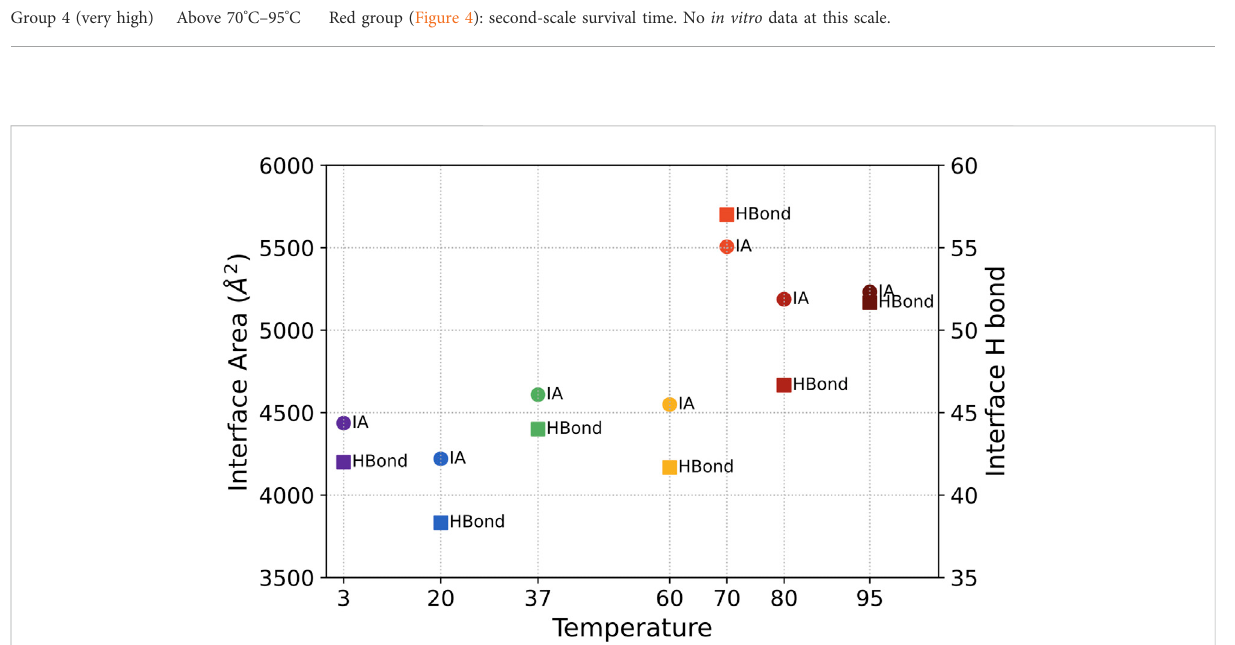
TABLE 1 Clustering of survival times based on conformational information of the S-protein. Group Temperatures Features descriptions Group 1 (cold) 3 ° C – 4 ° C Blue group (Figure 4): weeks of survival time. In vitro data: the virus at 4 ° C can survive for more than 2 weeks (Chin et al., 2020). Group 2 (normal) 20 ° C – 37 ° C Green group (Figure 4): day-scale survival time. In vitro data: 7 days at 20 ° C and 1 day at 37 ° C (Chin et al., 2020). Group 3 (high) 60 ° C – 70 ° C Orange group (Figure 4): minute-scale survival time. In vitro data: 10 min at 56 ° C and around 1 min at 70 ° C (Chin et al., 2020). Group 4 (very high) Above 70 ° C – 95 ° C Red group (Figure 4): second-scale survival time. No in vitro data at this scale.